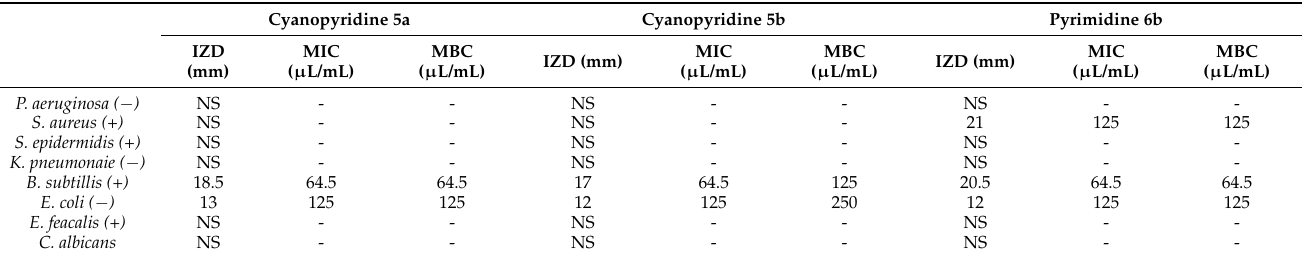
Table 4. Determination of the inhibition zone diameter of the synthesis of cyanopyridine derivatives ( 5a , 5b ) and pyrimidine ( 6b